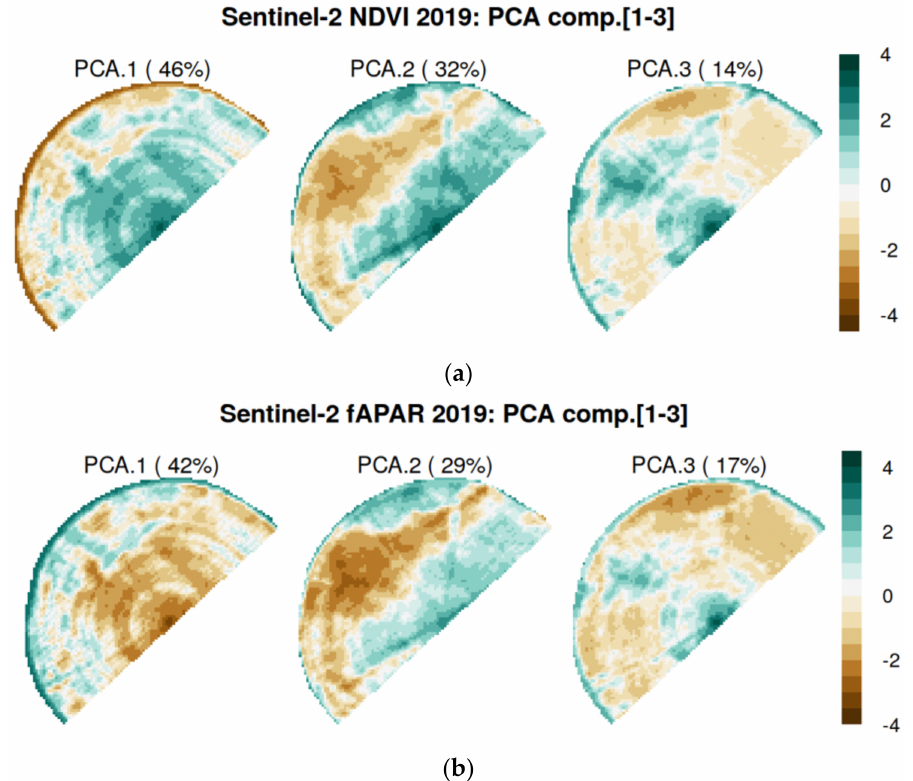
Figure 3. Principal components per biophysical indicator: NDVI ( a ) and fAPAR ( b ), labeled with proportion (%) of original variance